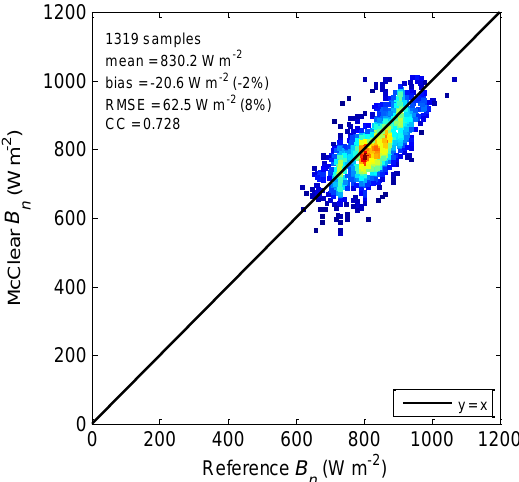
Figure 5. Scatter density plot between measurements of DNI and McClear estimates under cloud-free conditions at Aswan.